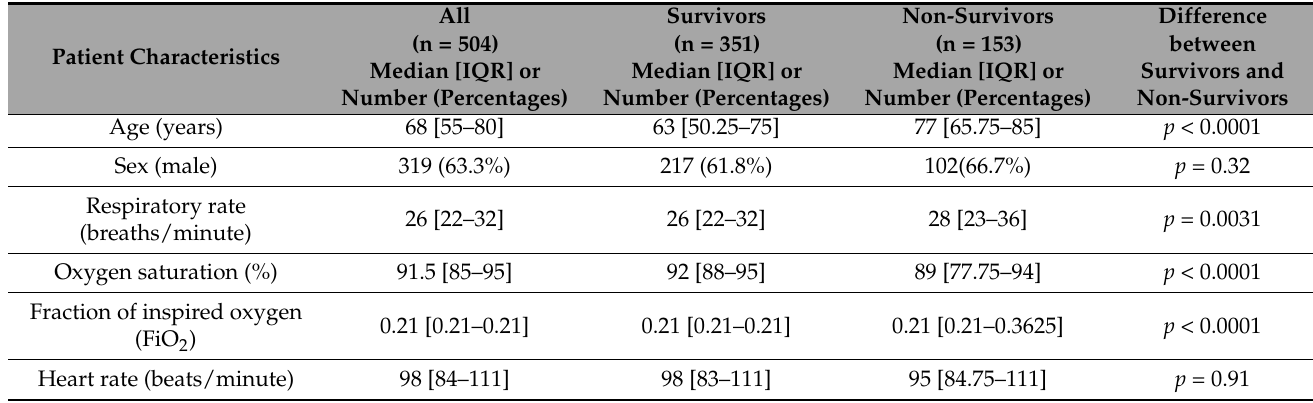
Table 1. The baseline characteristics of the study